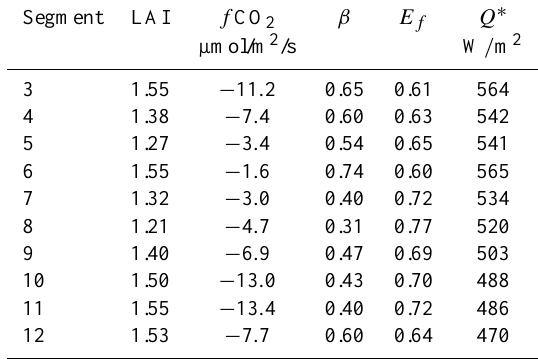
Fig. 6. Average leaf-area index per segment along flight track with 3km width at both sides for 15–22 April and for 6–13 September from MODIS (8-day composite; 250m resolution).